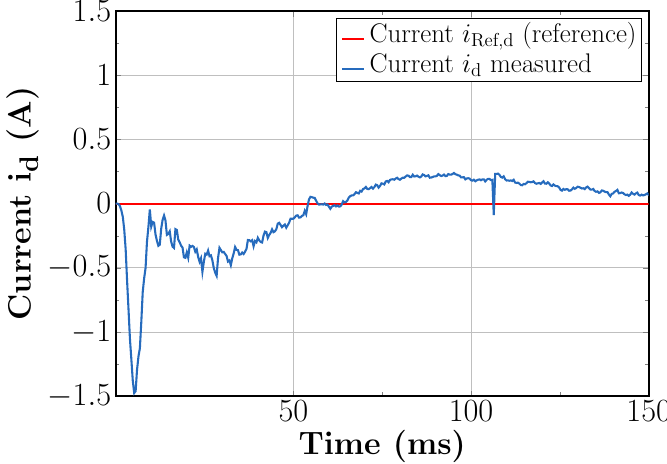
Figure 18. Sensorless speed control for 1200 RPM, current on the